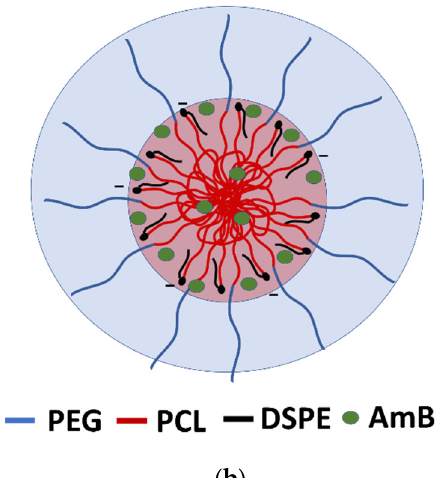
Figure 5. Characterisation of lyophilised formulations based on PP3 and PP3-DSPE. ( a ) DRX profiles and ( b ) DSC traces.